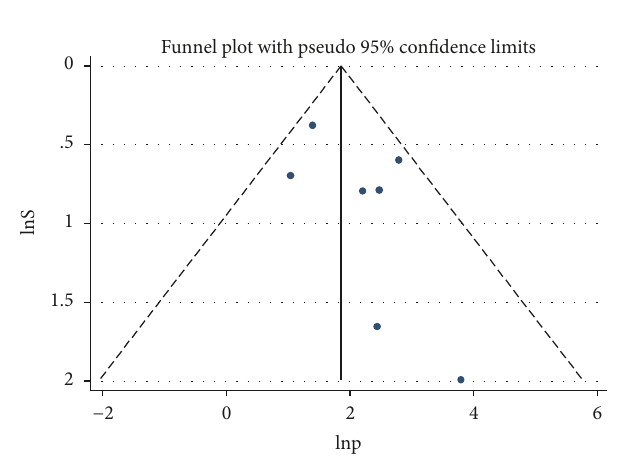
Figure 4: Funnel plot of the prevalence of malaria among pregnant